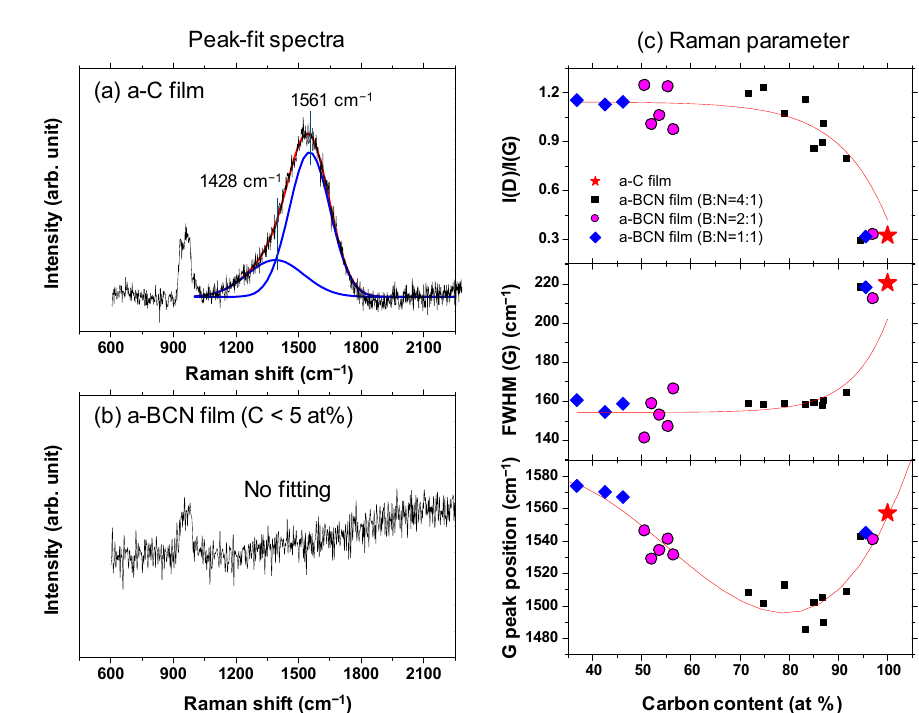
Figure 8. ( a , b ) Deconvoluted Raman spectra of the a-BCN films. ( c ) Raman parameters of the a-BCN films with respect to the carbon